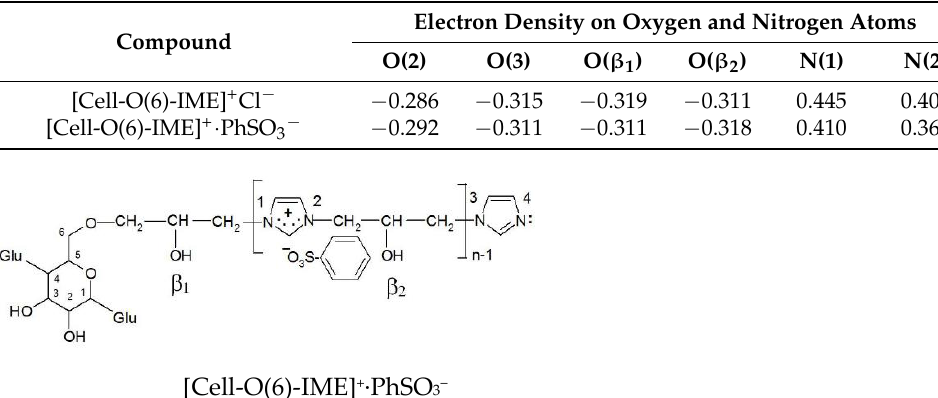
Figure 14. Chemical structure ionic pair cationised cellulose with benzenesulfonic acid for density electron analysis.